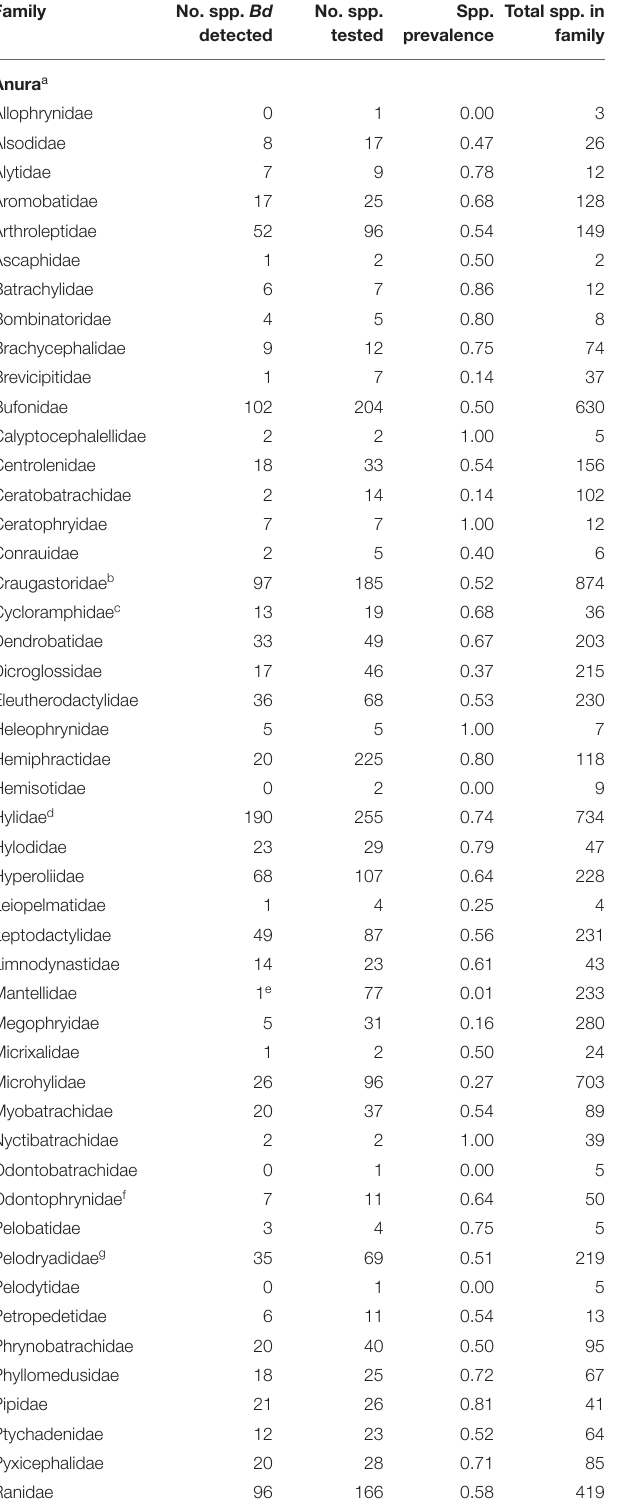
TABLE 3 | Family-level summary of Batrachochytrium dendrobatidis ( Bd ) detections among species sampled for Bd .